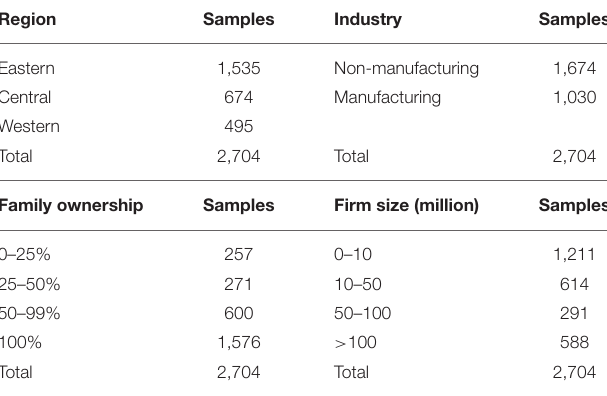
TABLE 1 | Description of sampled